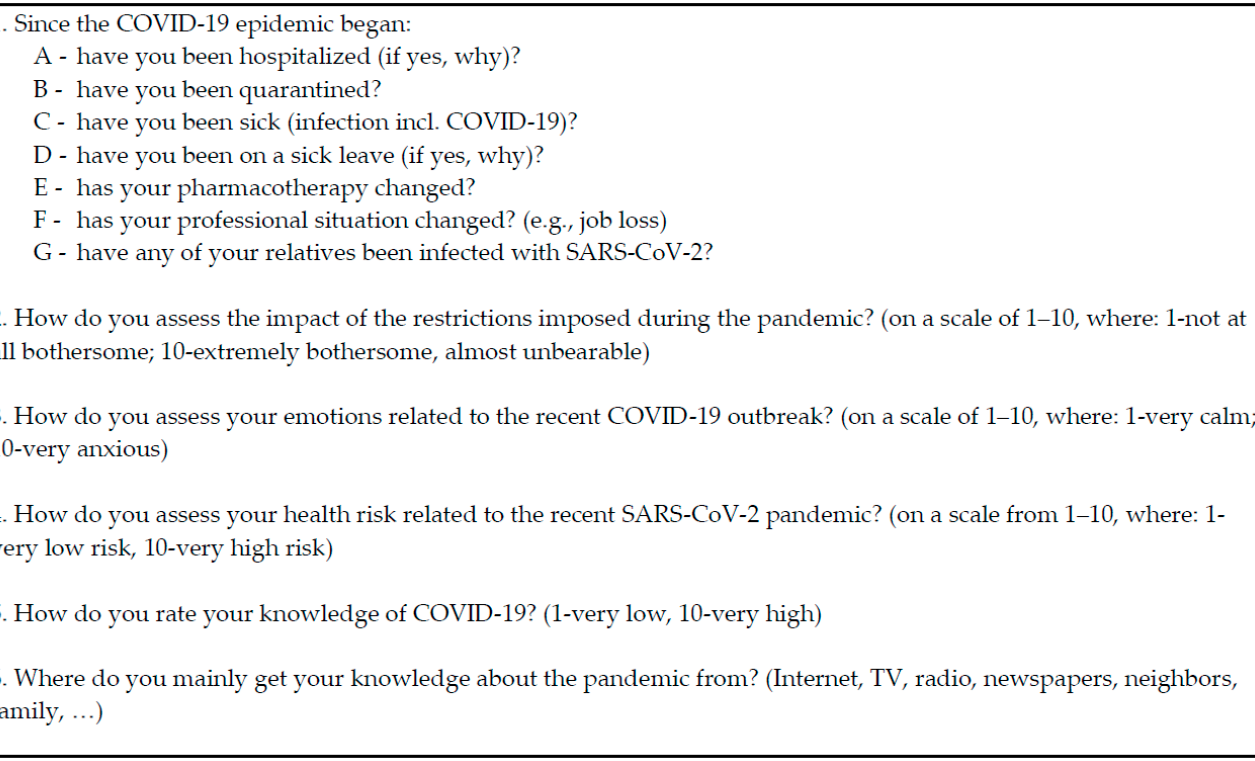
Figure 1. Questions regarding the situation of patients during the COVID-19 pandemic.